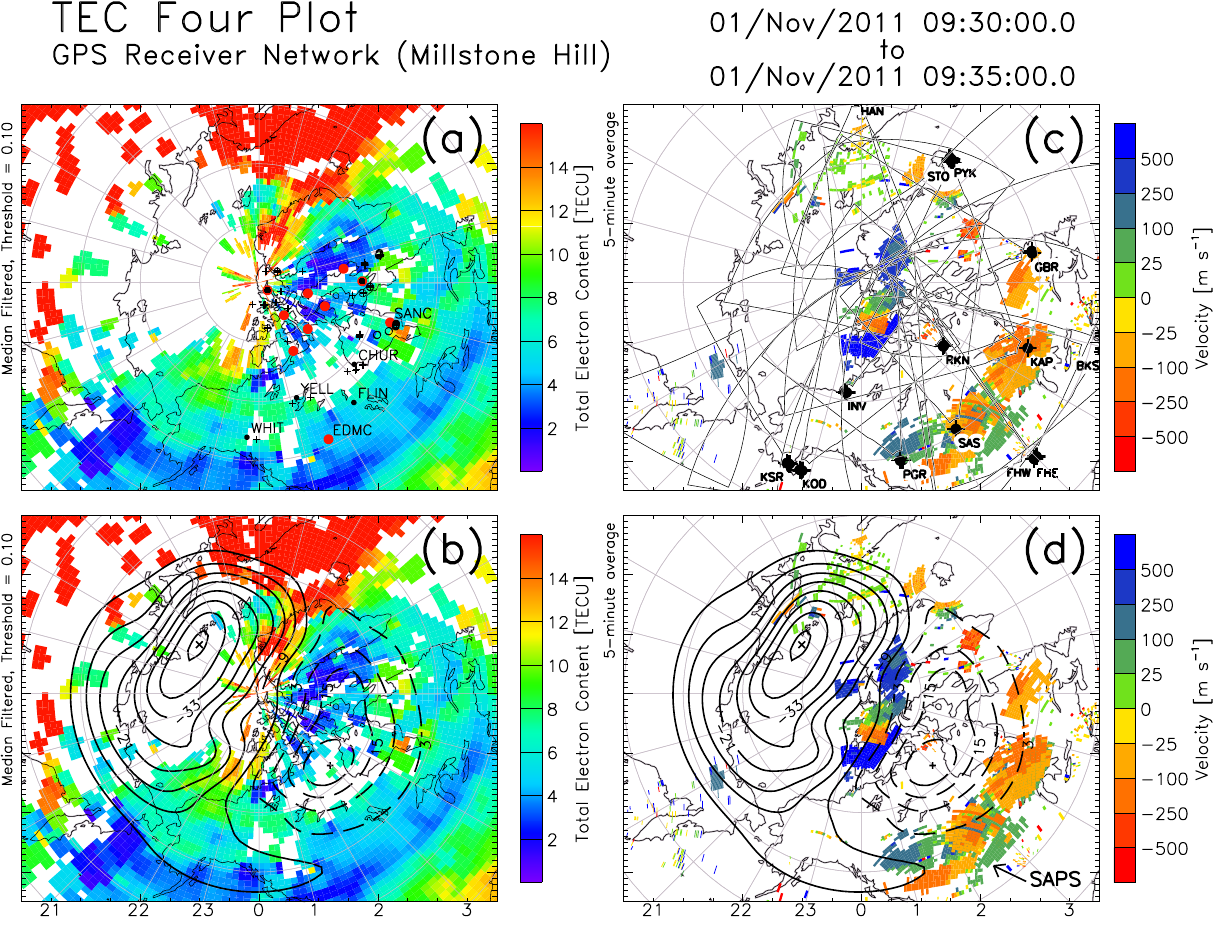
Fig. 3. (a) , (b) The 5-min median-filtered TEC mapped in coordinates of CGM latitude and MLT is overlaid (top) with CHAIN (red dots), IGS stations (black dots), IPPs for σ 8 > 0 . 1 radians (open circles), DPR > 2mms − 1 (crosses), and (bottom) the SuperDARN potential map. (c) , (d) The SuperDARN line-of-sight (LoS) velocities shown in colour on the CGM-MLT grid are overlaid with radar fields of view and the potential map. Blue indicates motion away from the radar and red